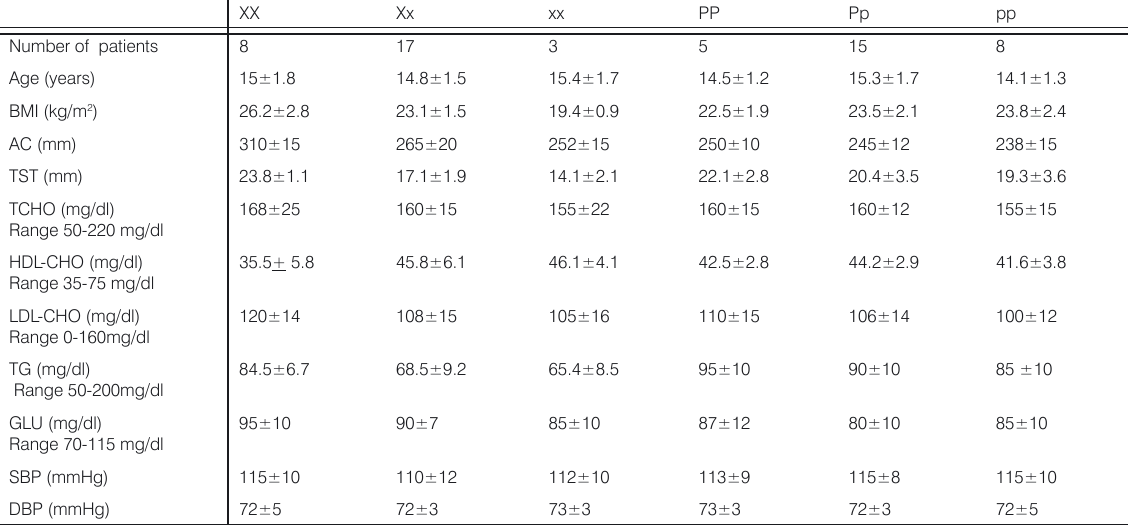
Table 4. Anthropometric, metabolic and blood pressure values in male teen-agers with Down Syndrome belonging to various ER genotypes.